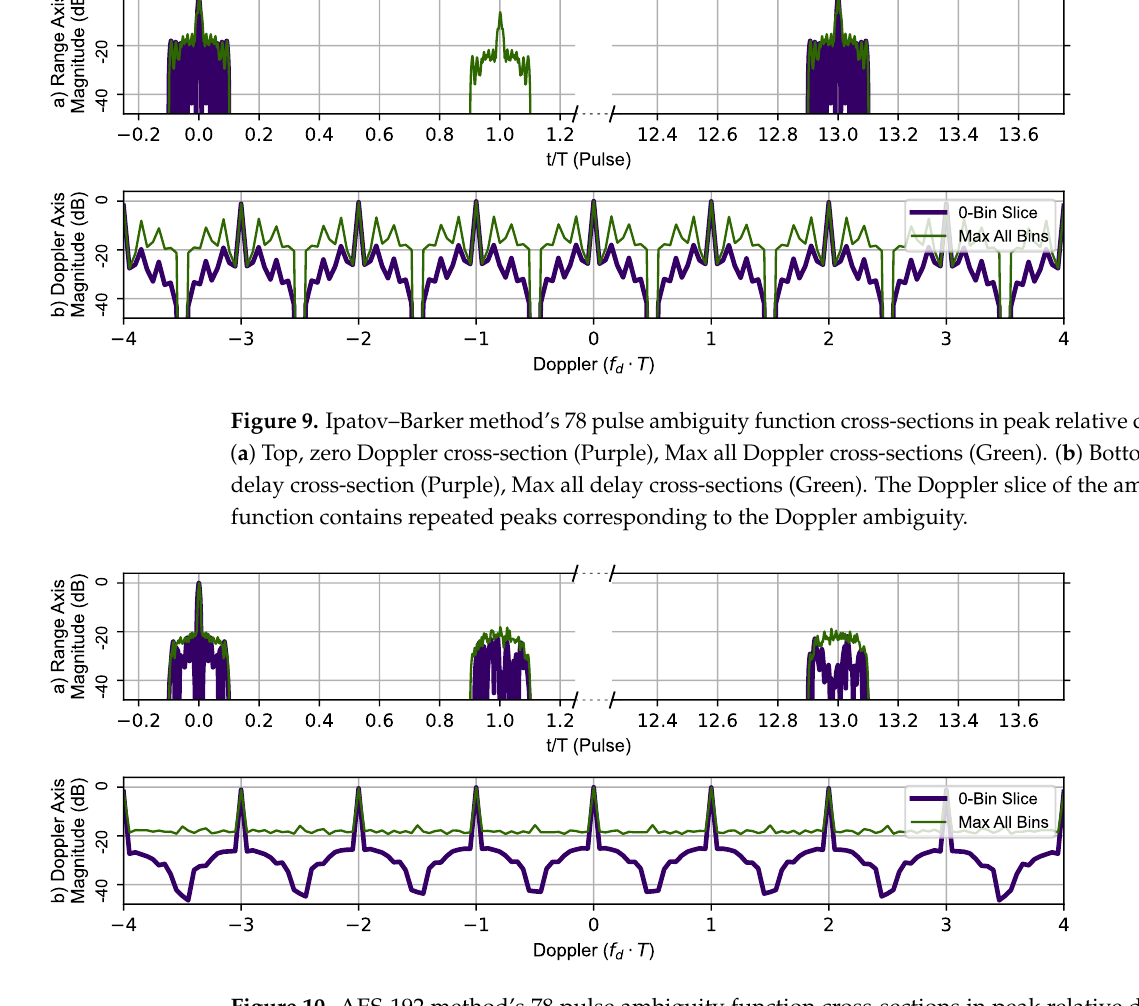
Figure 10. AES-192 method’s 78 pulse ambiguity function cross-sections in peak relative dB scale. ( a ) Top, zero Doppler cross-section (Purple), Max all Doppler cross-sections (Green). ( b ) Bottom, Zero delay cross-section (Purple), Max all delay cross-sections (Green). The Doppler slice of the ambiguity function contains repeated peaks corresponding to the Doppler